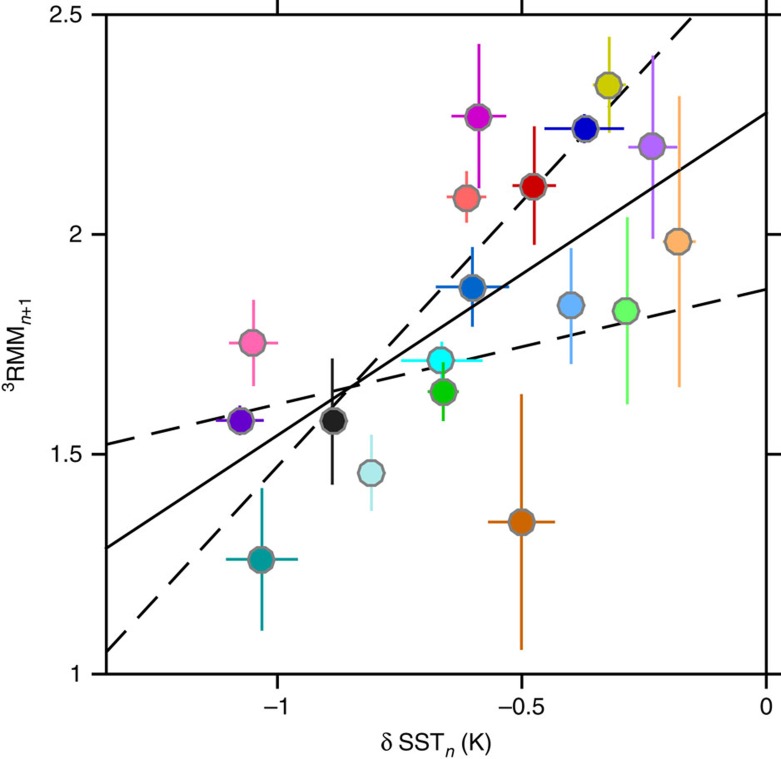
Negative feedback.Following pulse intensity (3RMMn+1) is plotted as a function of SST cooling from the initial pulse (δSSTn). The colours identify each of the paired pulses in Fig. 4. Confidence limits are defined in the Methods. The data are significantly correlated with r=0.64 [0.24, 0.85], P value=0.0046. The solid black line represents the regression 3RMMn+1=0.73 × δSSTn−2. The dashed black lines represent 95% confidence limits on the slope of the regression.